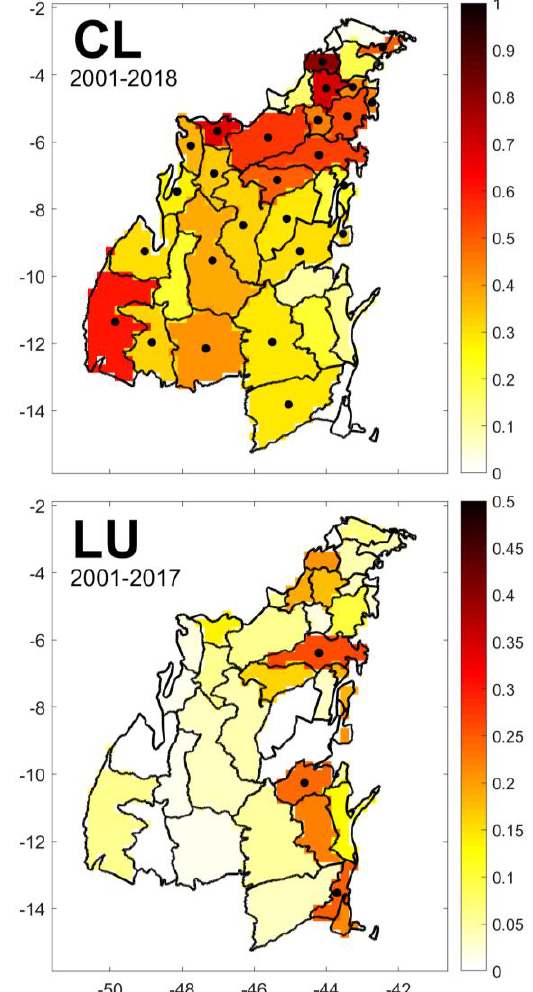
Figure 3. Coefficient of determination values between SBA and CL/LU (upper/lower figure) for MATOPIBA from 2001 to 2018/2017, respectively. Values close to 1 (0) indicate a high (low) relation between SBA and CL/LU. The filled (empty) circles represent significance below the 5 (10)%